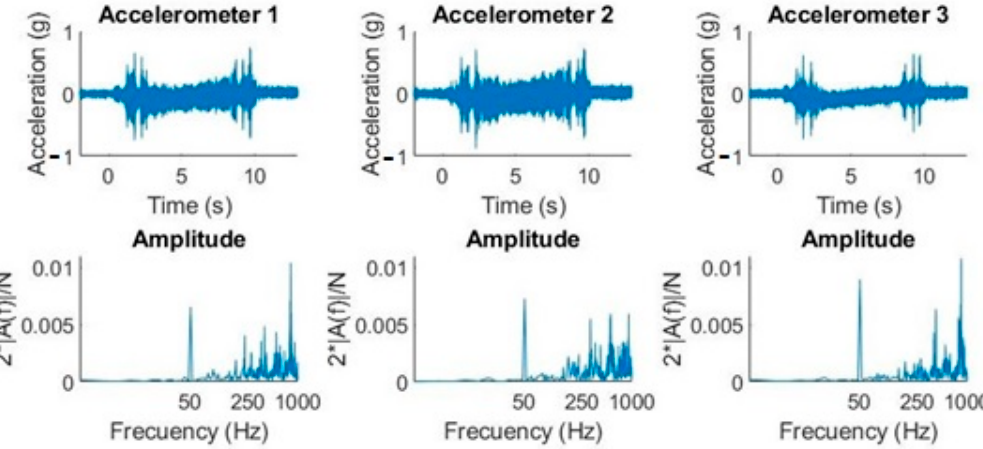
Figure 7. Graphs (acceleration-time and amplitude-frequency) with the three accelerometers in a declination movement from 0° to 40° and fixed straight ascension at 0°.